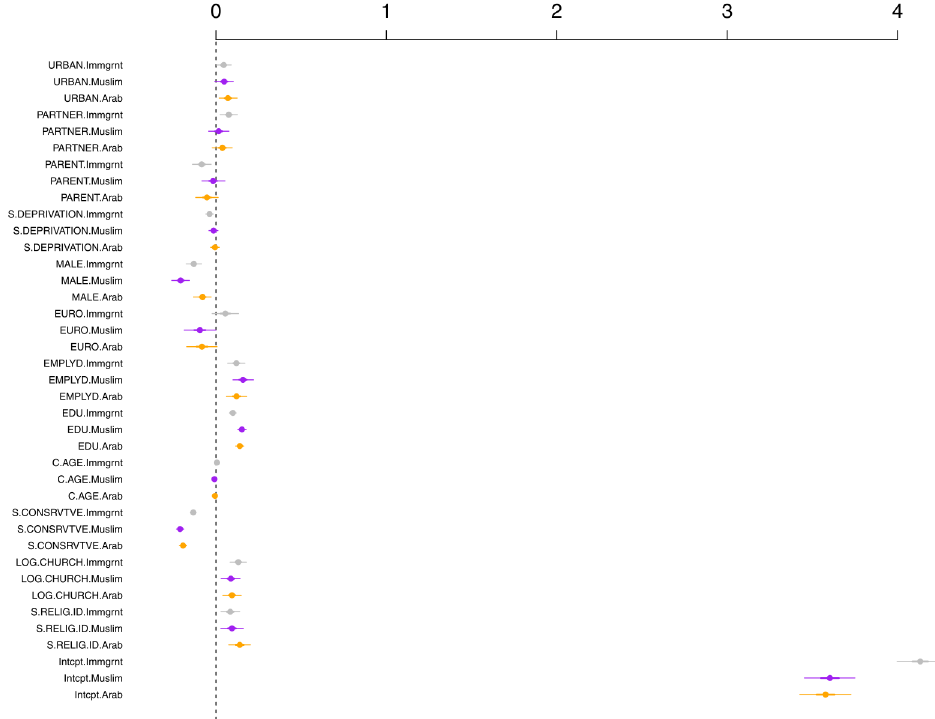
Fig 2. MCMC Solutions: Warmth to Arabs, Muslims,